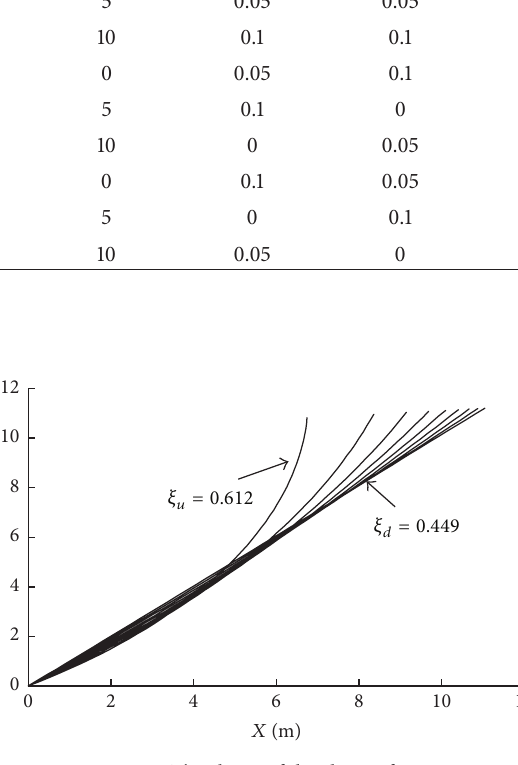
Figure 4: The shape of the slip